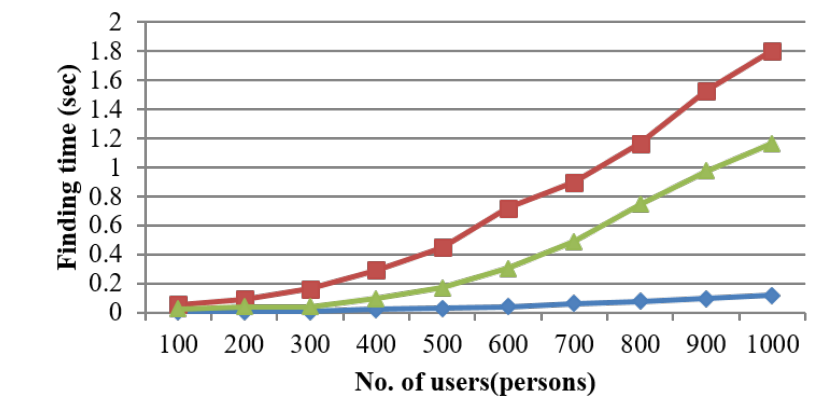
Figure 8. Finding time.